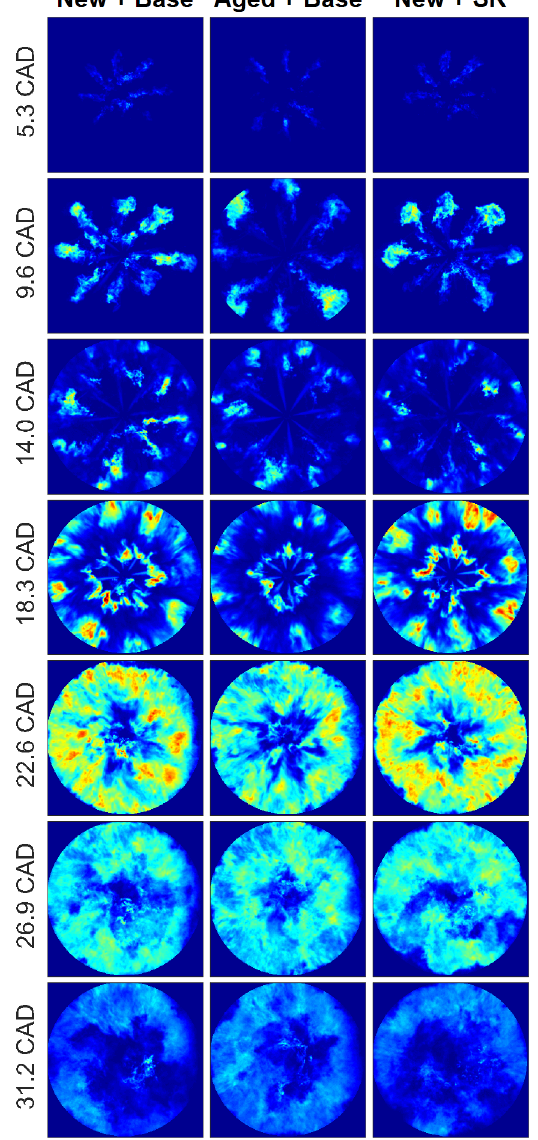
Figure 19. Natural luminosity signal during combustion processes at medium load, when using different fuels with different injectors.